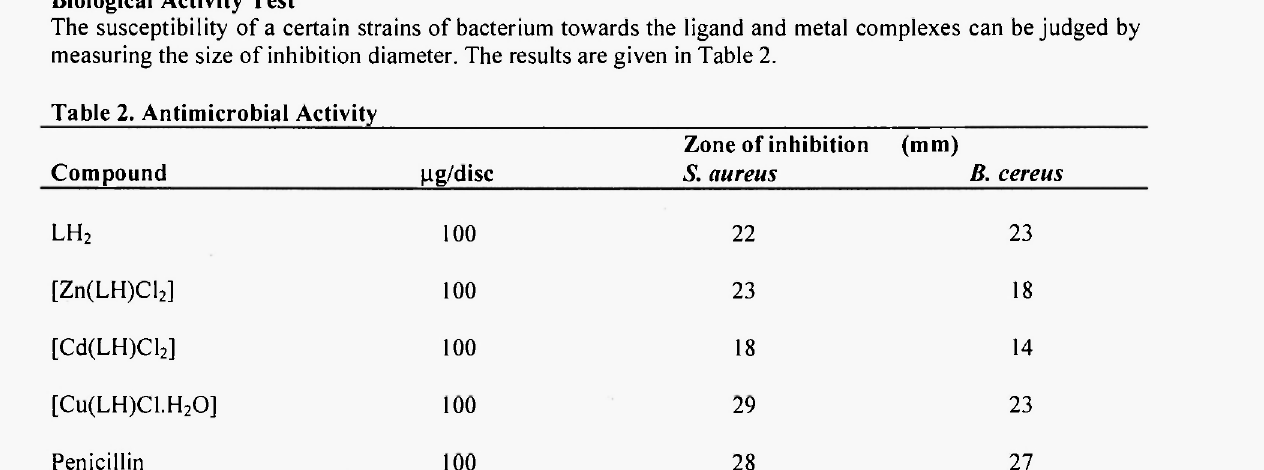
Zone of inhibition (mm)